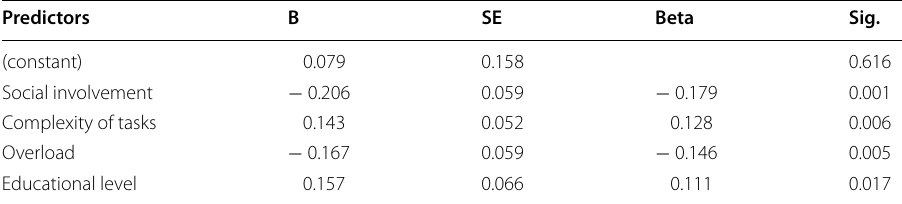
B regression coefficient, SE standard error. R 2 Table 6 Narrow model 4: regression model on drop-out intention